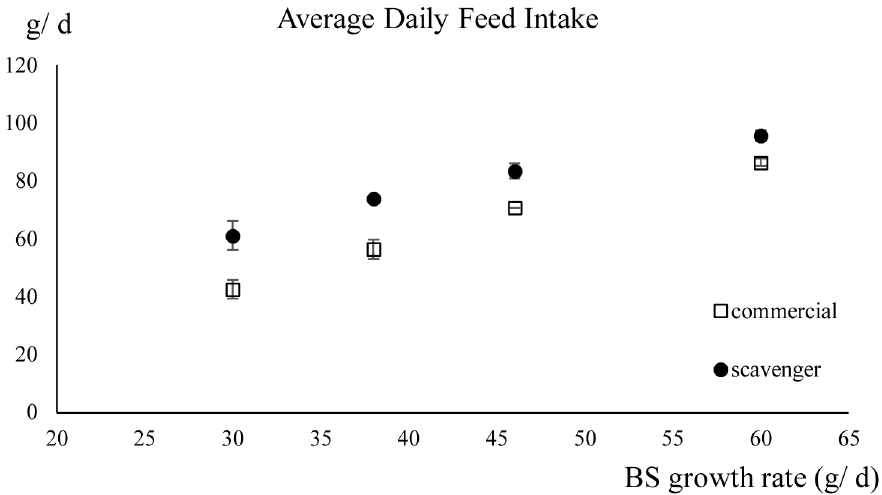
46g/ d (CobbSasso), 38g/ d (Sasso) and 30g/ d (Sussex).